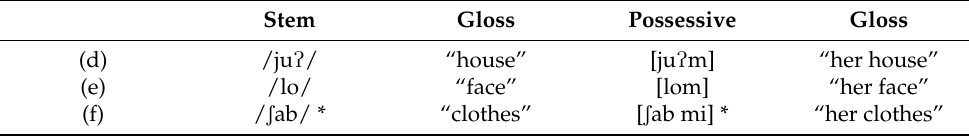
Table 2. Person marker in possessive case in Texmelucan Zapotec (Speck 1978, p.